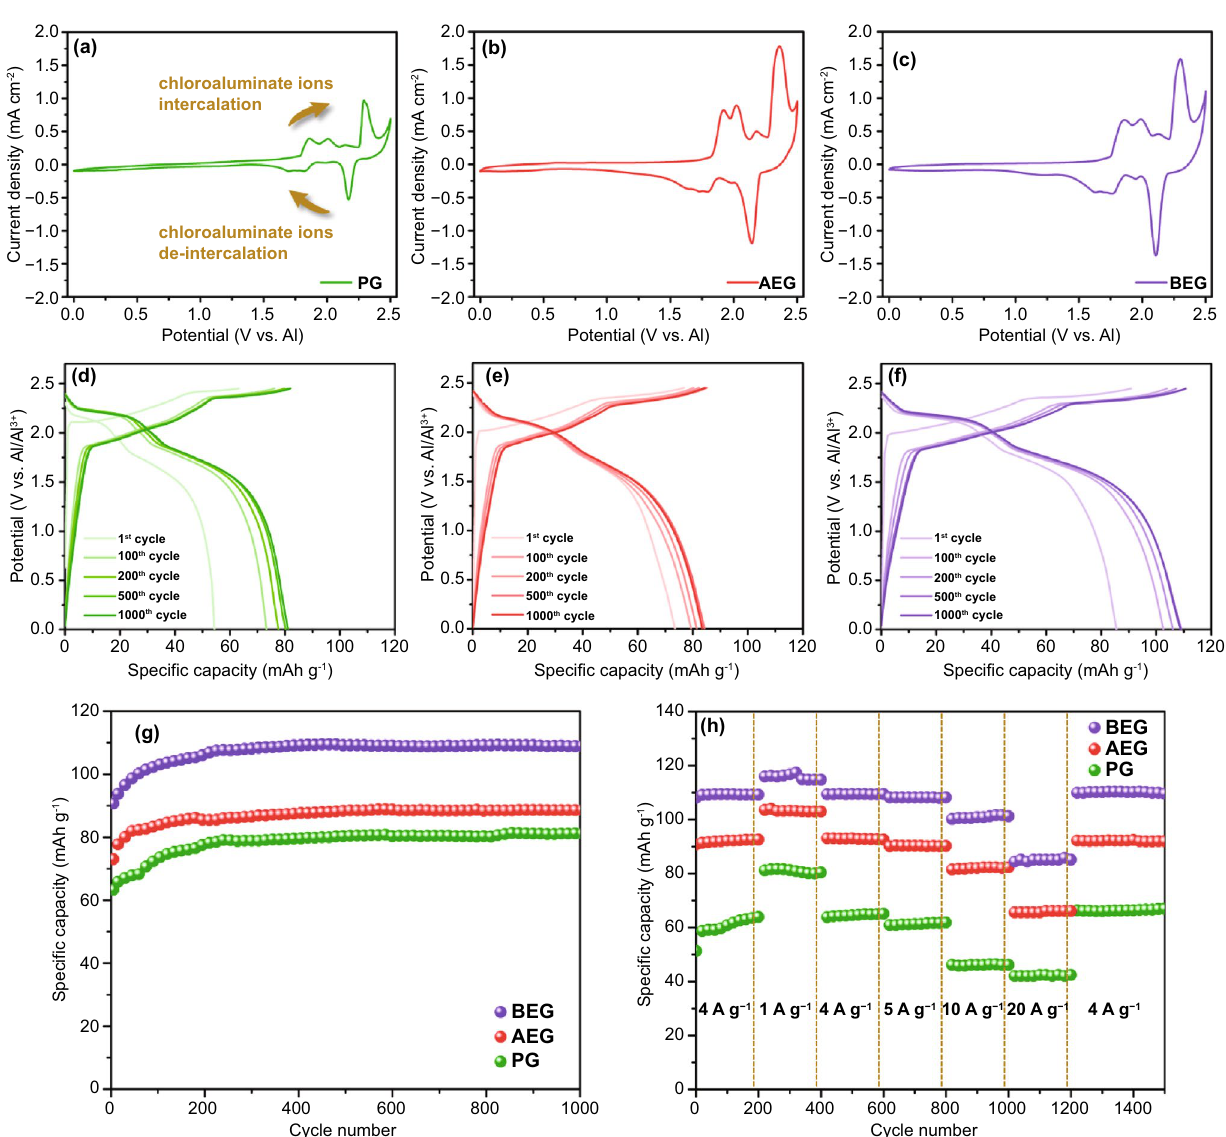
Fig. 4 a–c CV curves and d–f charge–discharge voltage profiles at a current density of 4 A g −1 from 1st to 1000th cycles for PG, AEG, and BEG samples. g Cyclic stability of PG, AEG, and BEG samples at a current rate of 4 A g −1 and h the rate capability of PG, AEG, and BEG sam- ples at various current densities ranging from 1 to 20 A g